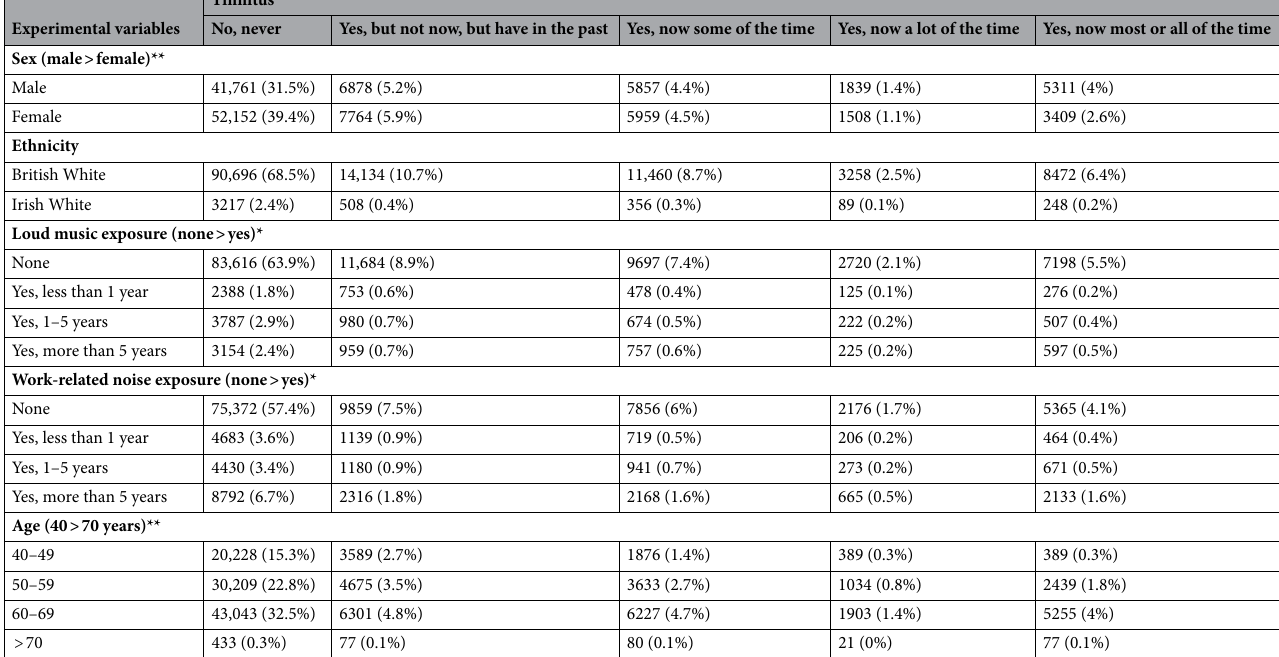
Table 1. Prevalence of tinnitus across the experimental variables (N = 132,438). **Chi square p < 10 –100 , *Chi square p < 10 –10